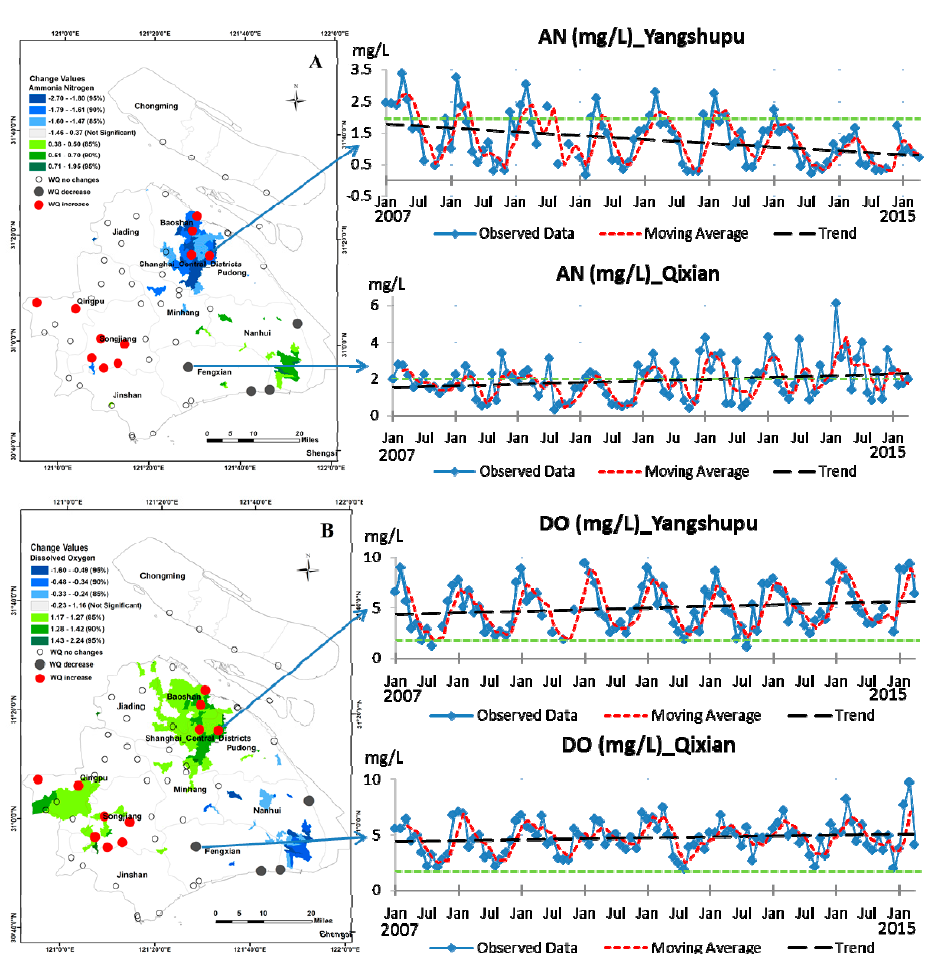
Figure 8. Water quality changes in stations from 2007 to 2015: ( A ) ammonia nitrogen changes and ( B ) DO changes. Note: Green dashed lines indicate the severely polluted surface water content level, according to China environmental quality standards.